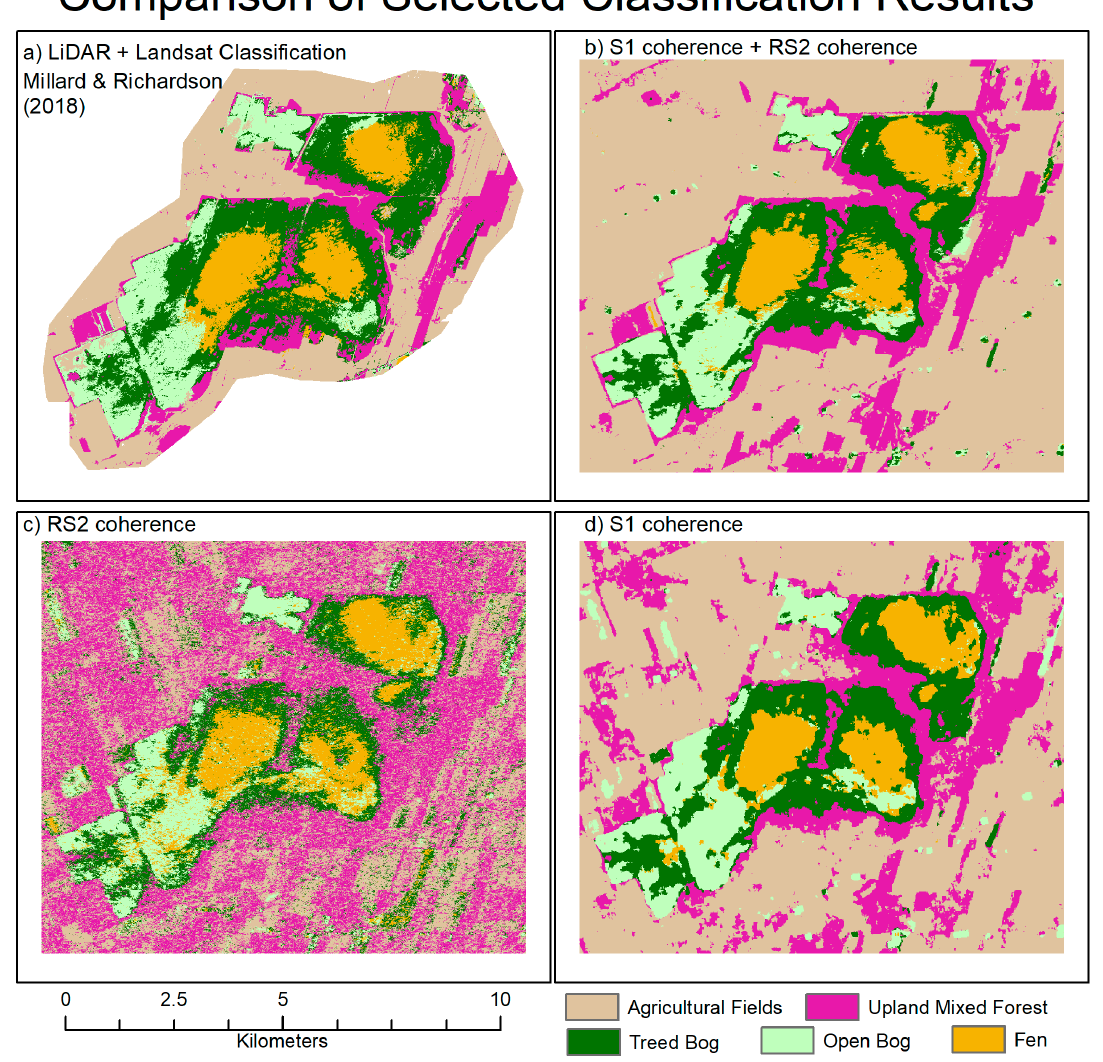
Figure 5. Comparison of coherence-based classifications. ( a ) Previous classification created using a combination of Landsat-8 and LiDAR data used in Millard and Richardson, 2018. ( b ) S1-coh + RS2-coh = 81.2% accuracy, ( c ) RS2-coh = 59.7% accuracy, ( d ) S1-coh = 80.9%